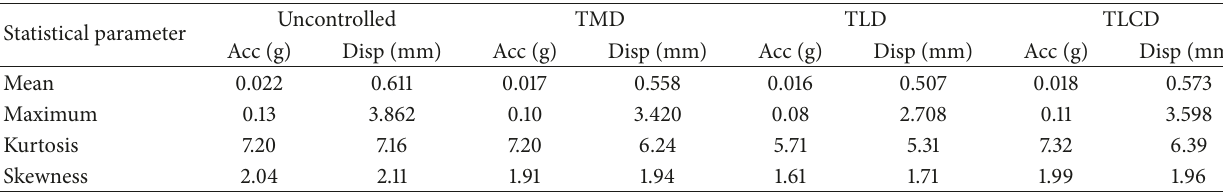
Figure 4: (a) The excitation signal of seismic design and (b) acceleration responses for the top floor of the uncontrolled structural, TMD, TLD, and TLCD controlled system. Table 1: Statistical parameters for the acceleration and displacement